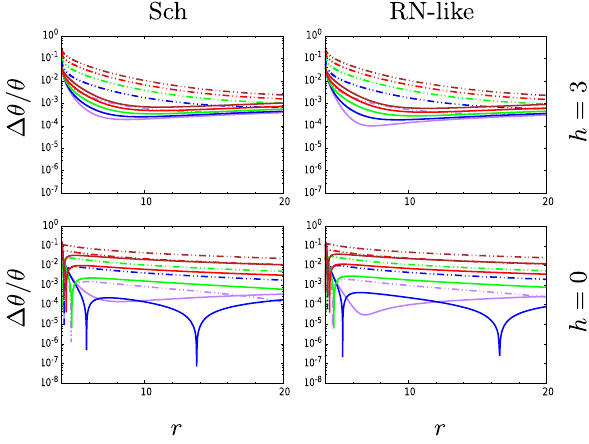
Fig. 12 θ as a function of δ . q ∗ = − ( 0 . 50 M ) 2 , R = 4 M . The purple, blue, green, red and brown lines correspond respectively to (cid:11) = 0 . 1, 0 . 2, 0 . 3, 0 . 4 and 0 . 5. Continuous lines were obtained numerically [Eq. (4.8)]whiledashedlineswereobtainedanalyticallyfromEq.(5.2)(with plasma correction). Errors are minimum for small δ and grow with it, overestimating θ max